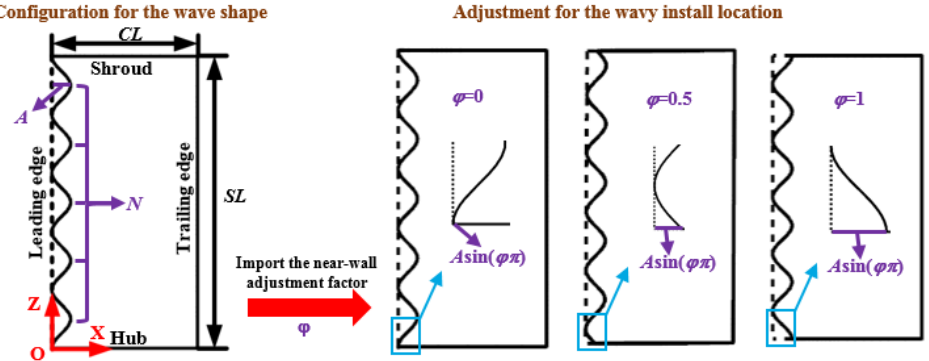
Figure 7. Wavy leading edge parameterization.